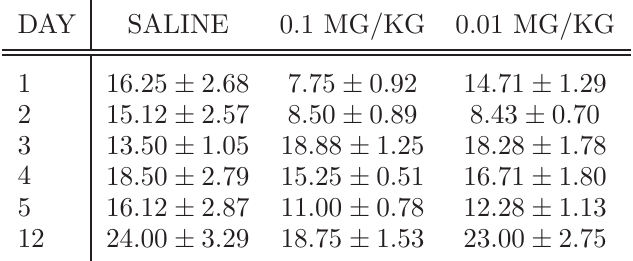
Table 4 Effects of CGP76291 on active avoidance